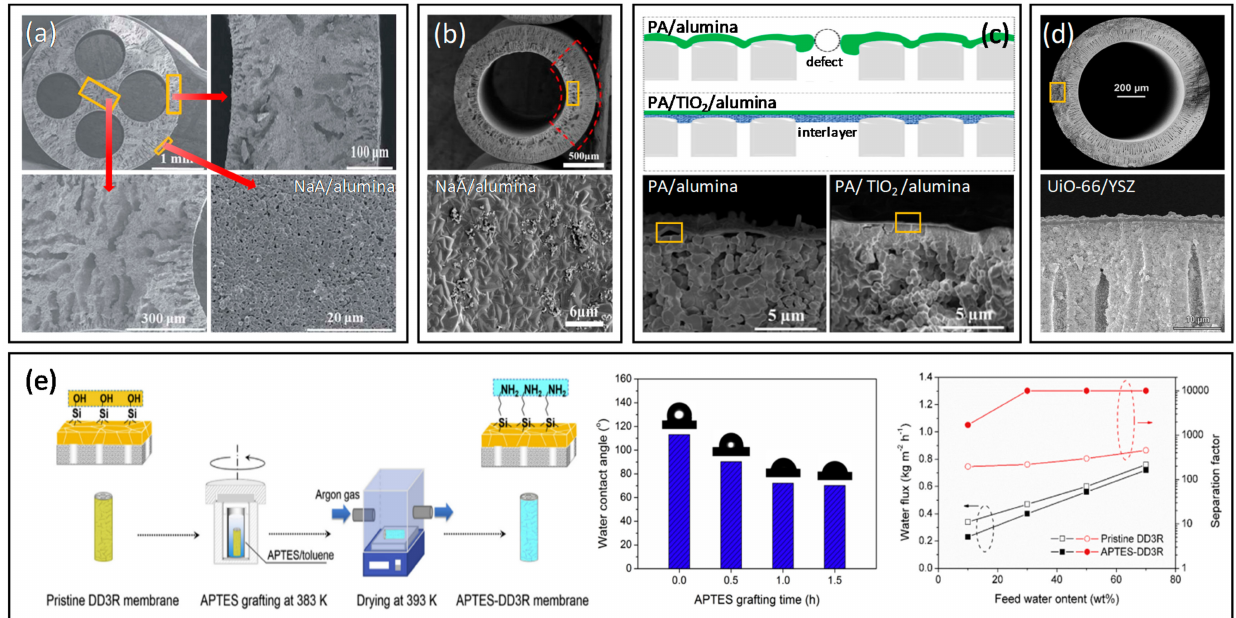
Figure 13. SEM images of NaA zeolites supported on the ( a ) outer surface and ( b ) inner surface of the